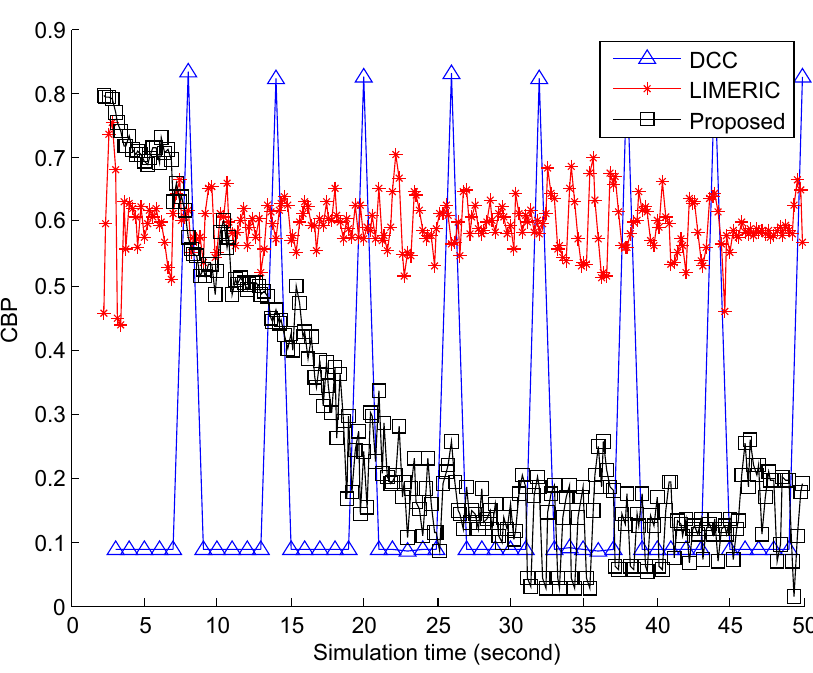
Figure 2. CBP comparison of the reference